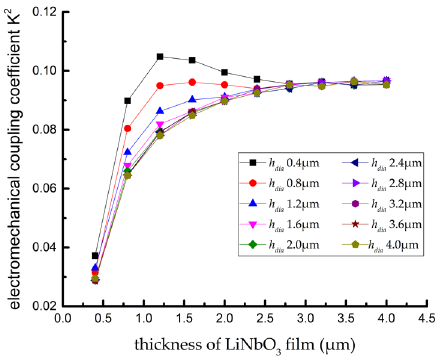
Figure 7. Distribution curve of electromechanical coupling coefficient K 2.